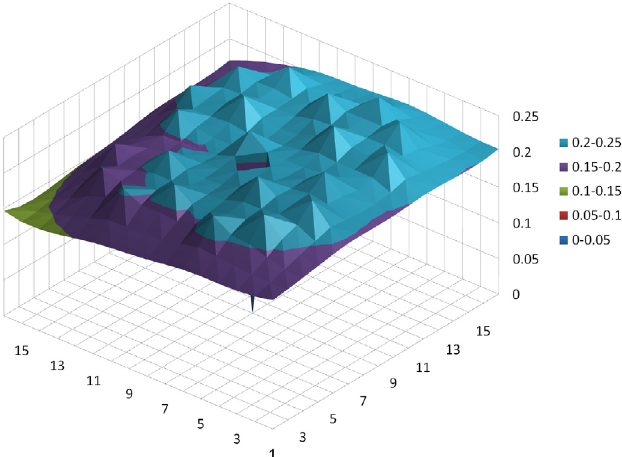
Fig. 3. Pin to pin fl ux distribution for assembly 53 on the fi rst